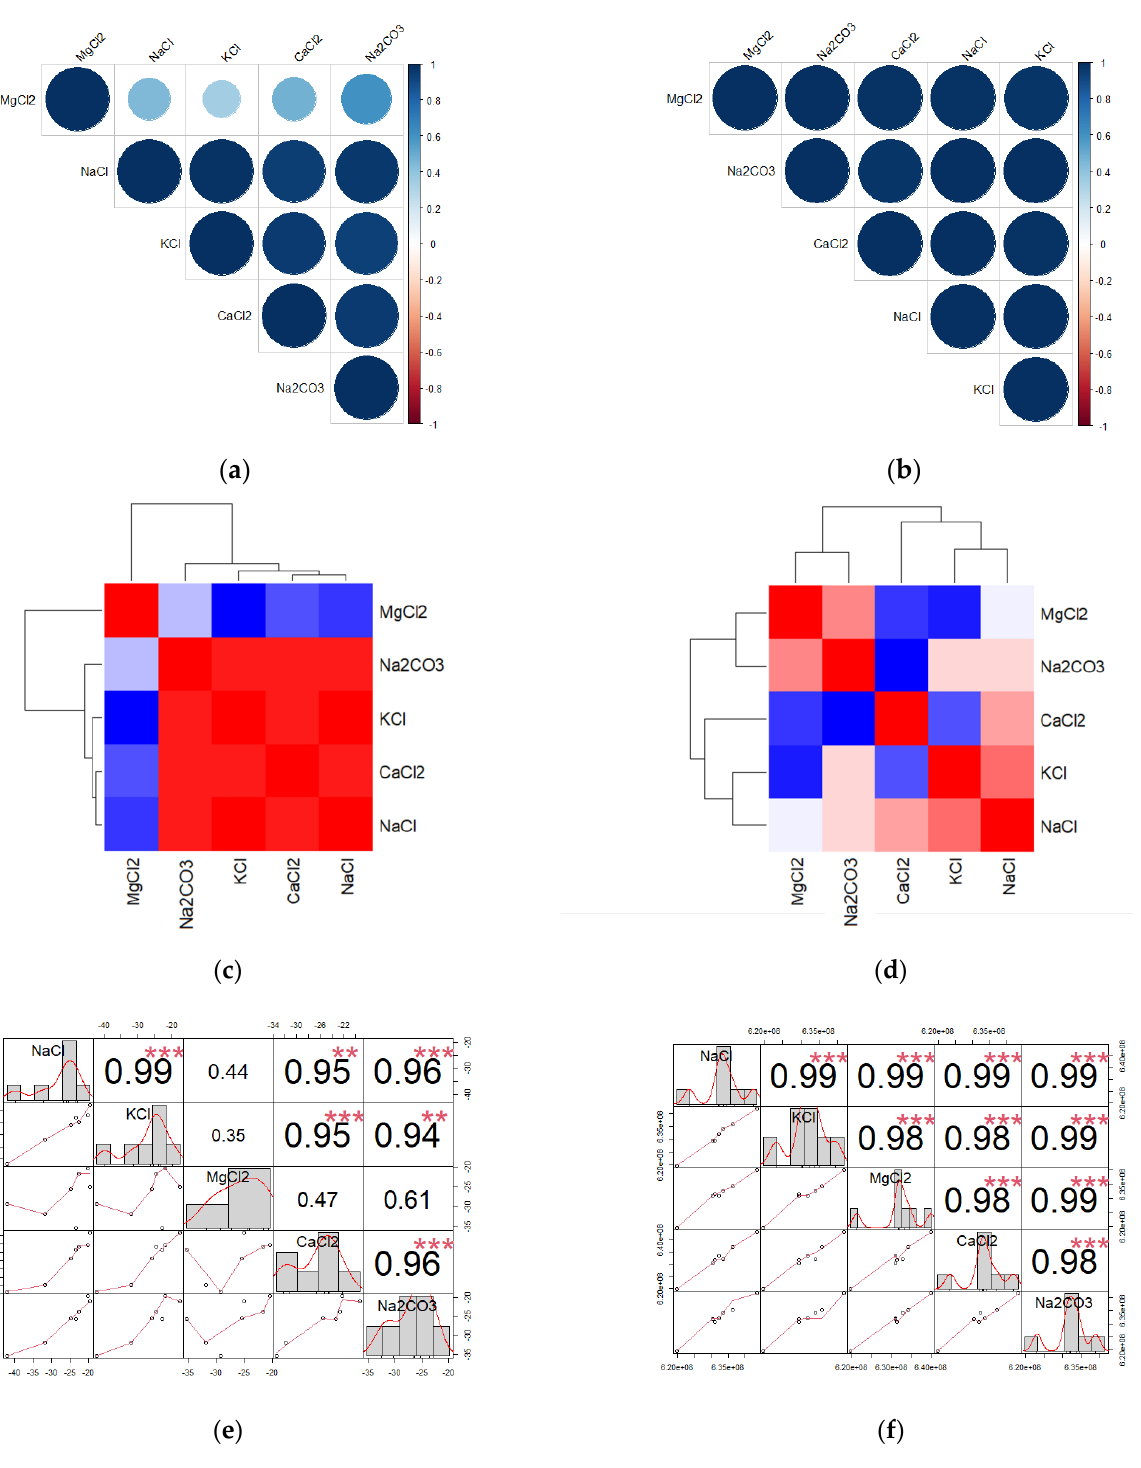
Figure 14. The correlation between all independent variables from the raw data obtained from the second resonance peak: ( a ) correlation plot (S 11 ), ( b ) correlation plot (F r ), ( c ) heatmap plot (S 11 ) (red color corresponds to the highest values), ( d ) heatmap plot (F r ) (red color corresponds to the highest values), ( e ) chart plot (S 11 ), and ( f ) chart plot (F r ). Each significance level is represented by a unique symbol, with the p-values 0.001 (***), 0.01 (**), and 0.05 (*).